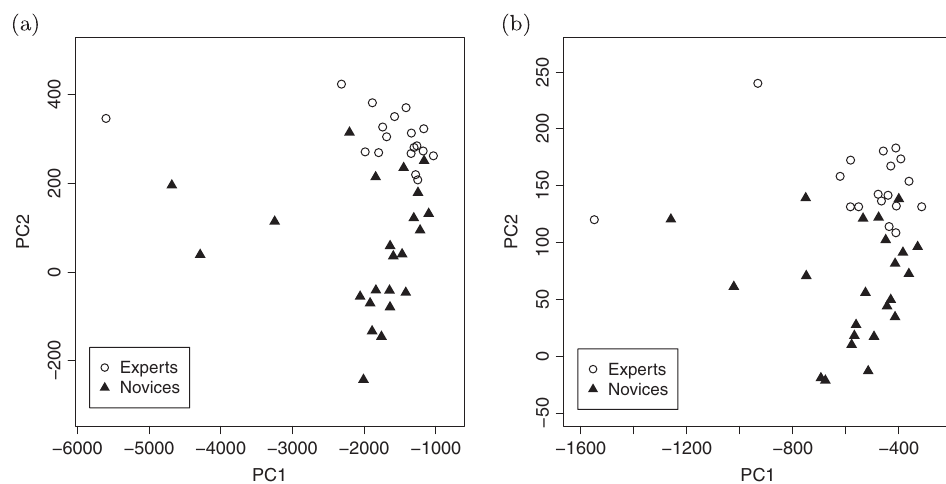
FIG. 1. (a) The PCA plot of the sorters for the entire set of problems from our previous study [2]. Both a Cramer’s test ( p ¼ 0 : 048 ) and a Hotelling’s test ( p < 10 (cid:1) 5 ) find the expert and novice groups to be distinct at a 95% confidence level. (b) The PCA plot of the sorters considering only the problems from Singh’s study. Both a Cramer’s test ( p ¼ 0 : 041 ) and a Hotelling’s test ( p < 10 (cid:1) 5 ) find the expert and novice groups to be distinct at a 95% confidence level. For both plots, PC1 is the coordinate along the first principal axis, and PC2 is the coordinate along the second principal axis. Sorters known by us to be experts are marked by circles while sorters known by us to be novices are marked by filled triangles. The second principal component discriminates experts from novices, as experts congregate higher on this axis than